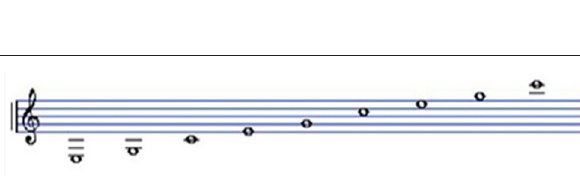
FIGURE 2 | The musical scale task used for psychoacoustic